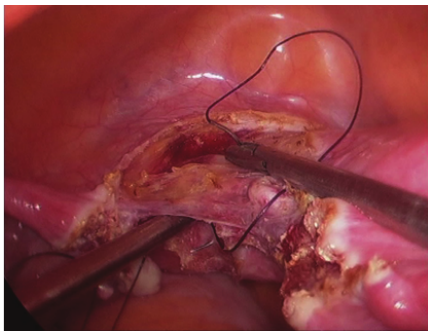
Figure 2: Prior ligation of uterine